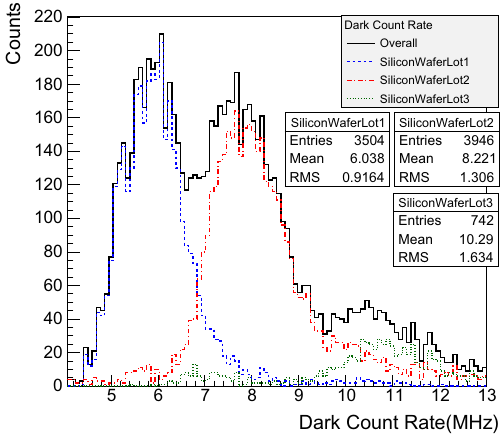
Fig. 4 The DCR distribution at 20 ◦ C. DCR is defined per a